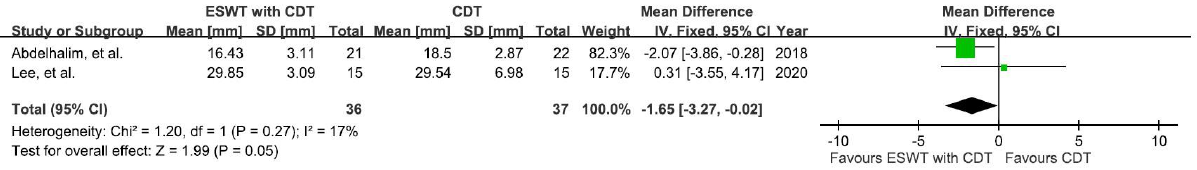
Figure 7. Mean difference (95%CI) in the effect of additional ESWT compared with CDT alone on the shoulder ROM of BCRL.